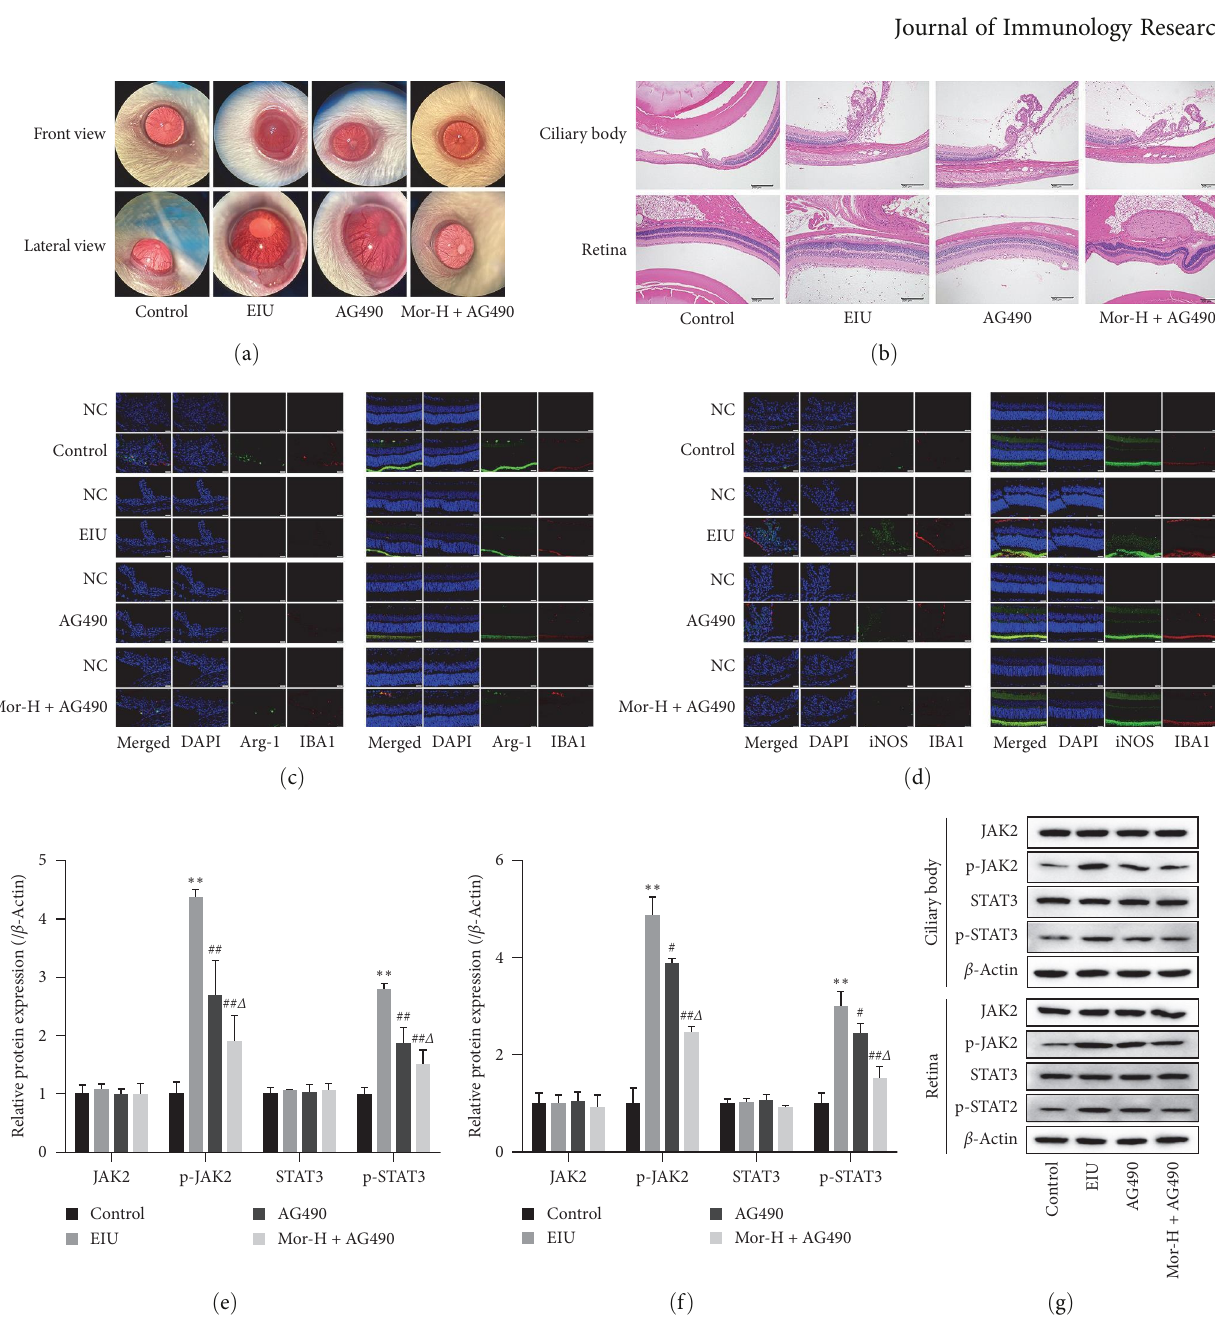
F IGURE 5: Morroniside treatment affects the JAK/STAT signaling pathway in EIU mice. (a) In fl ammation in each group observed under slit lamp microscopy (frontal and lateral views). (b) Observation of hematoxylin – eosin staining in ciliary body and retinal tissues (100 × , scale bar, 200 μ m). (c) Expression of Arg-1 in the ciliary body and retinal tissues of mice (40 × , scale bar, 20 μ m). (d) Expression of iNOS in the ciliary body and retinal tissues of mice (40 × , scale bar, 20 μ m). (e, g) Protein expression of JAK2, p-JAK2, STAT3, and p-STAT3 in ciliary body tissues. (f, g) Protein expression of JAK2, p-JAK2, STAT3, and p-STAT3 in retinal tissues. Means Æ SD from three independent samples are shown. Data in western blot assays were expressed after normalization to β -actin levels. Comparison with the control group: ∗∗ P < 0 : 01; comparison with the EIU group: # P < 0 : 05, ## P < 0 : 01; comparison with the AG490 group: Δ P < 0 :